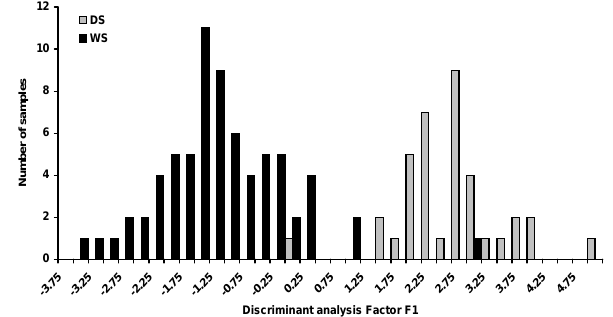
Fig. 5. Discrimination of samplings DS and WS based on major elements along factor